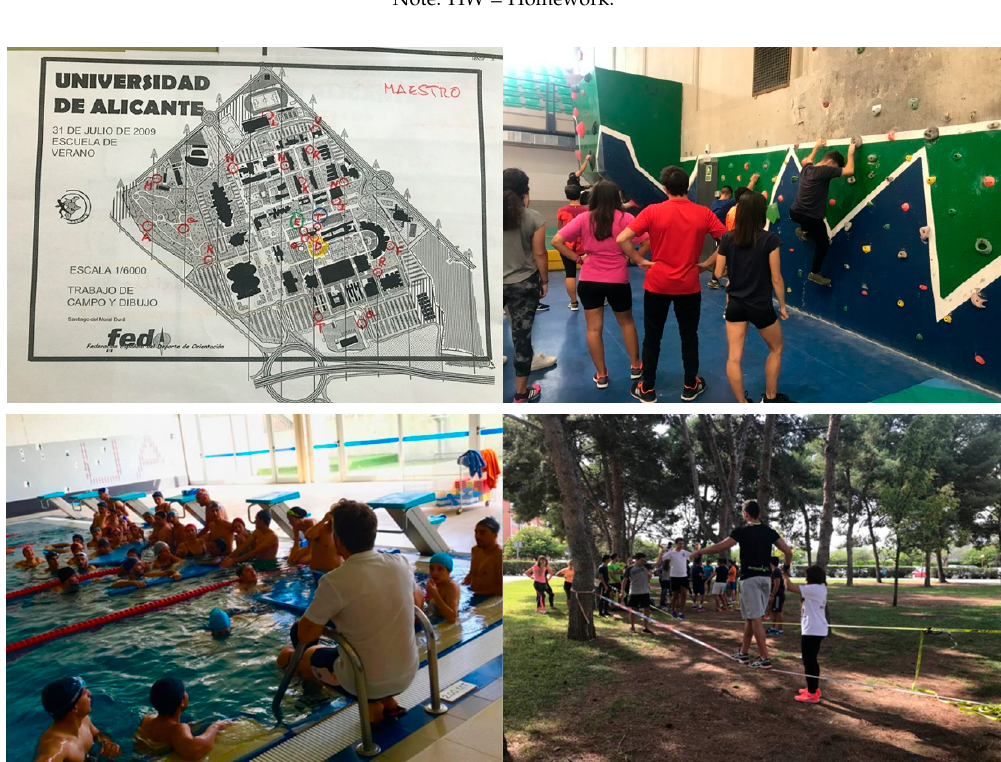
Figure 2. Di ff erent lessons carried out during the Figure 2. Different lessons carried out during the intervention.